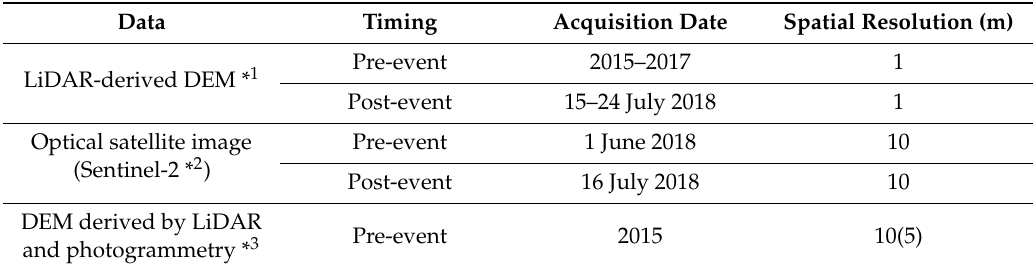
Table 1. Characteristics of spatial data analyzed in this study. Spatial resolution of DEM for debris flow propagation analysis is converted to 10 m from 5 m by